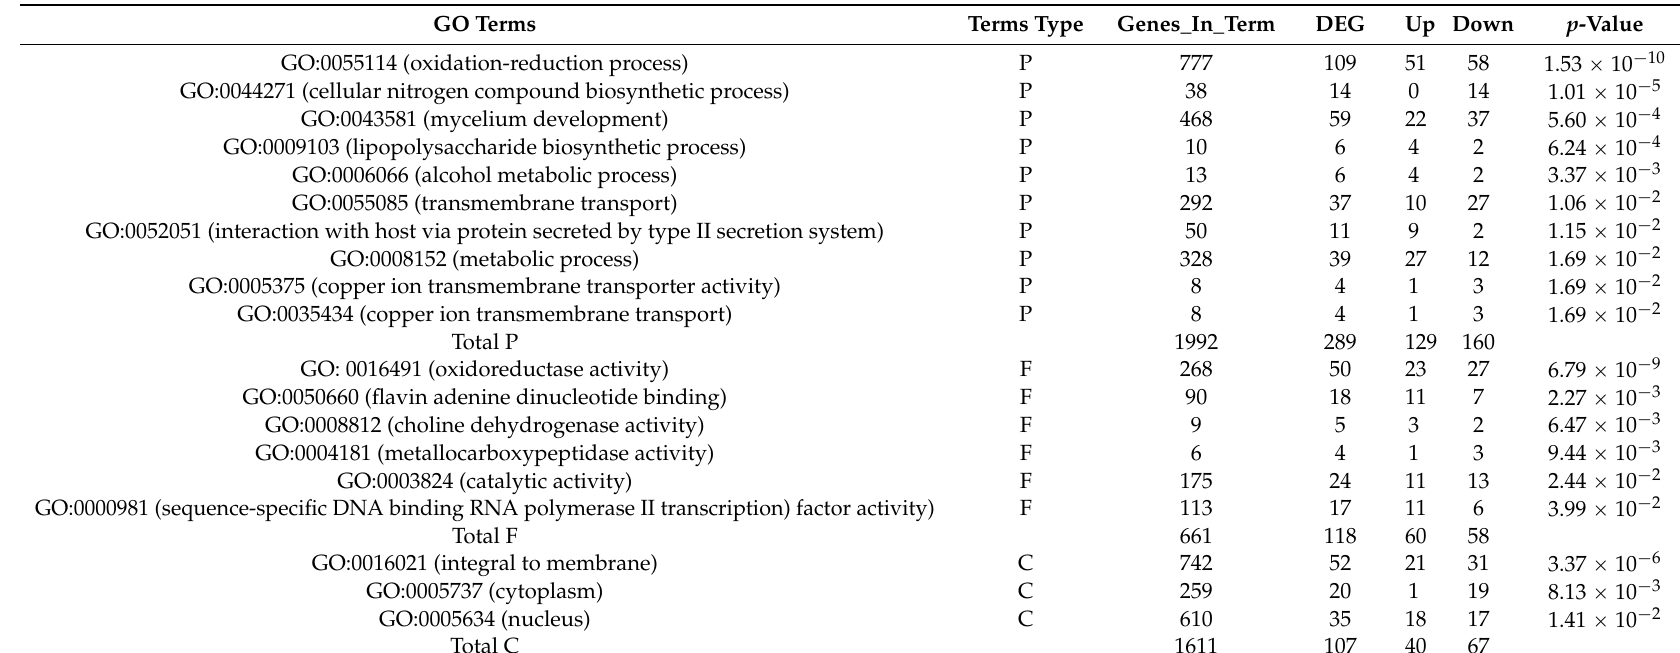
Table 2. GO analysis for differentially expressed